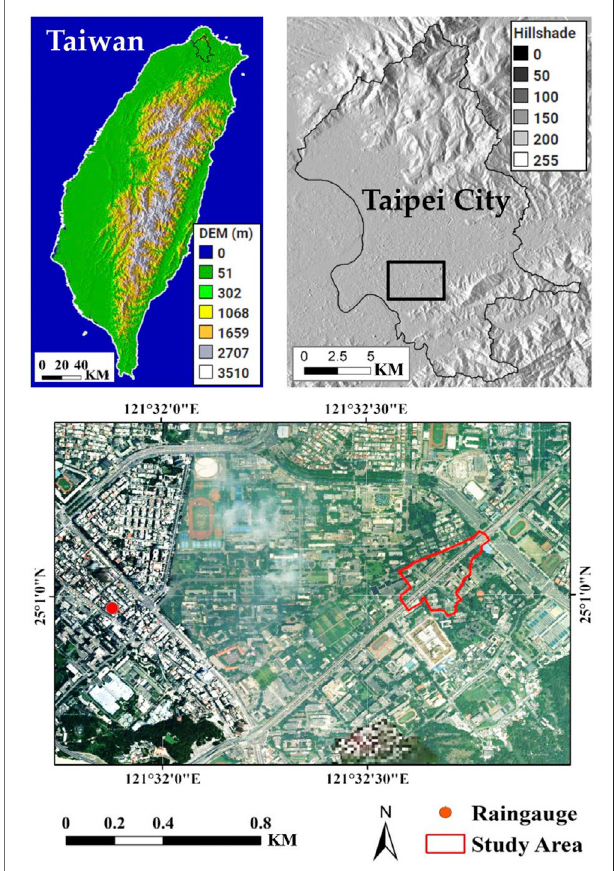
FIGURE 2 | Study area (red polygon) at Gongguan, Taipei, Taiwan (the Google Earth images sourced from © Google, Landsat/Copernicus, and the shading image was derived from SRTM with 30 m